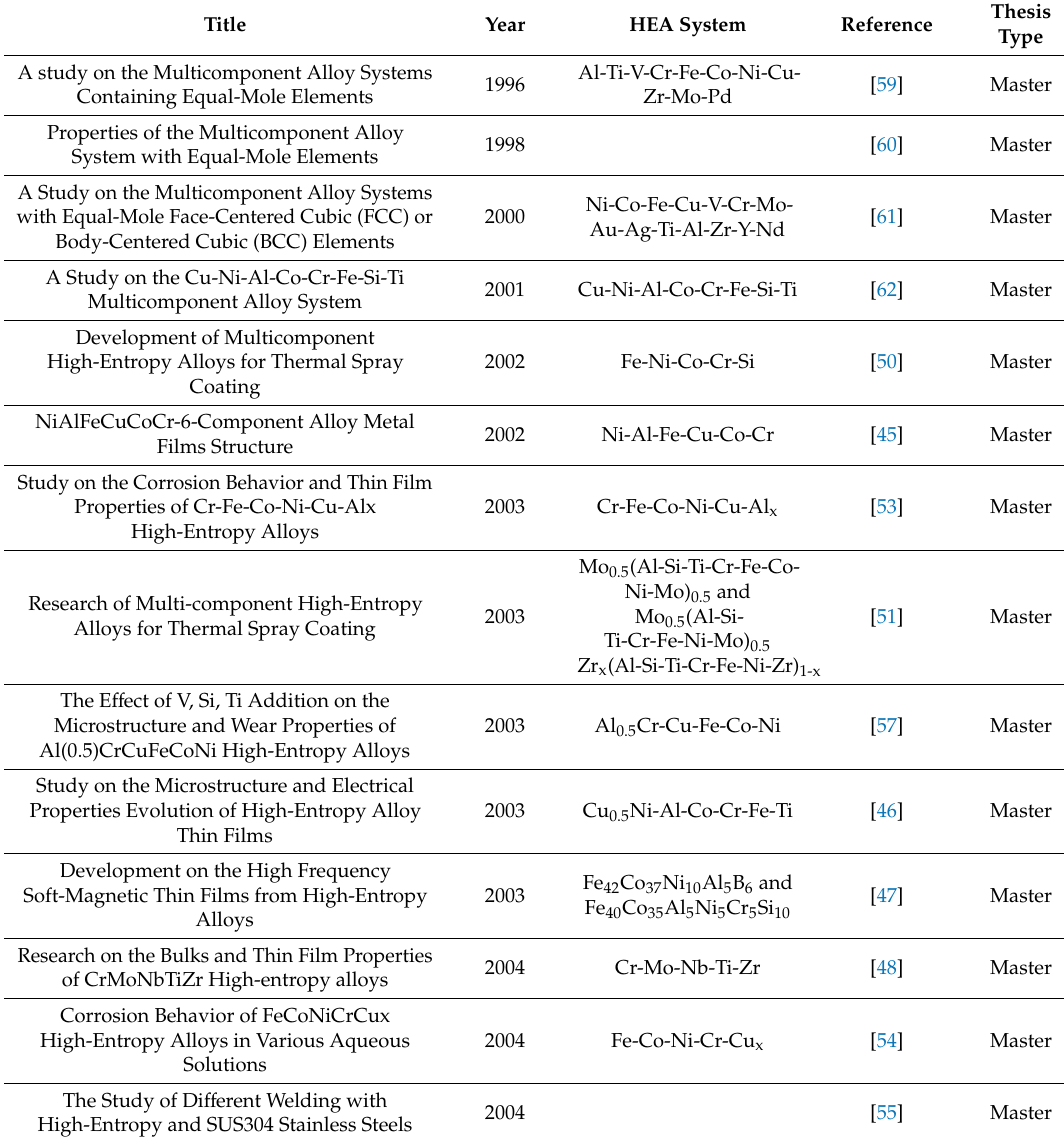
Table 1. Summary of research into high-entropy alloy (HEA) combinatorial approaches from 1996 to 2004. Title Year HEA System Reference